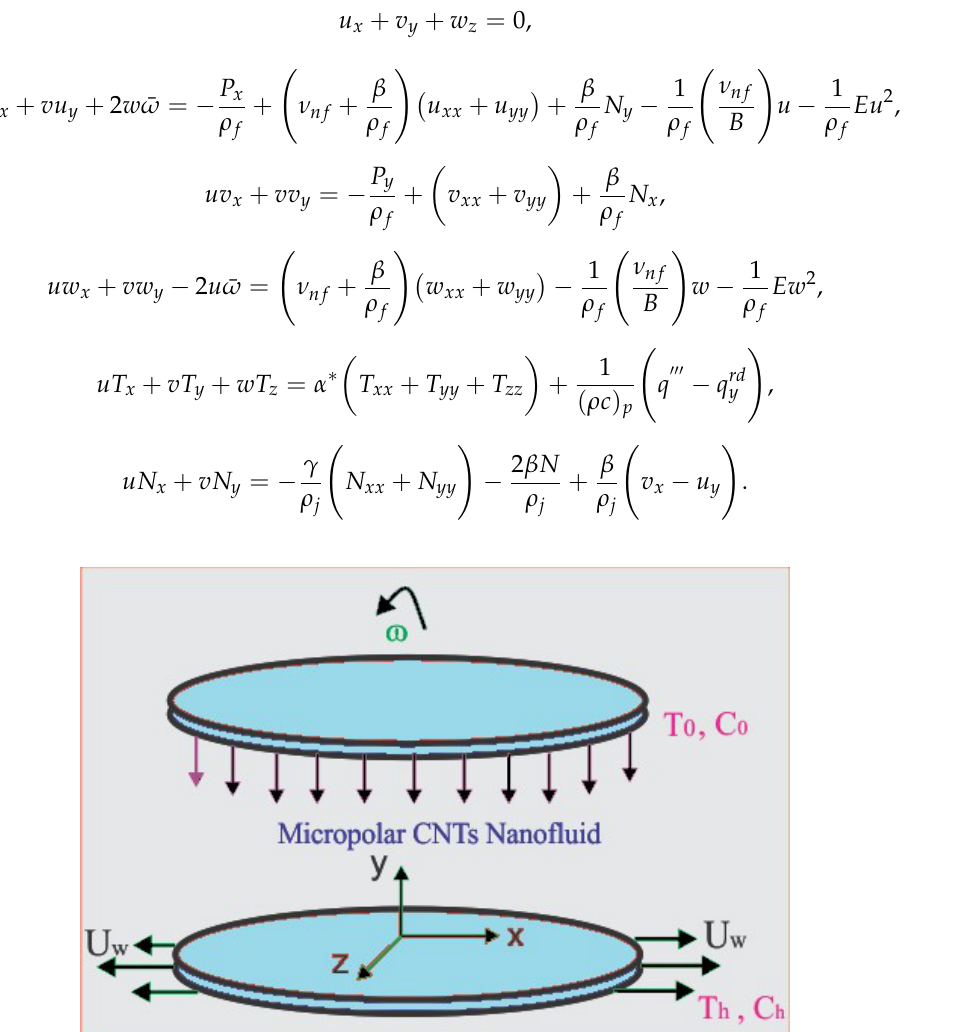
Figure 1. Geometrical sketch of the